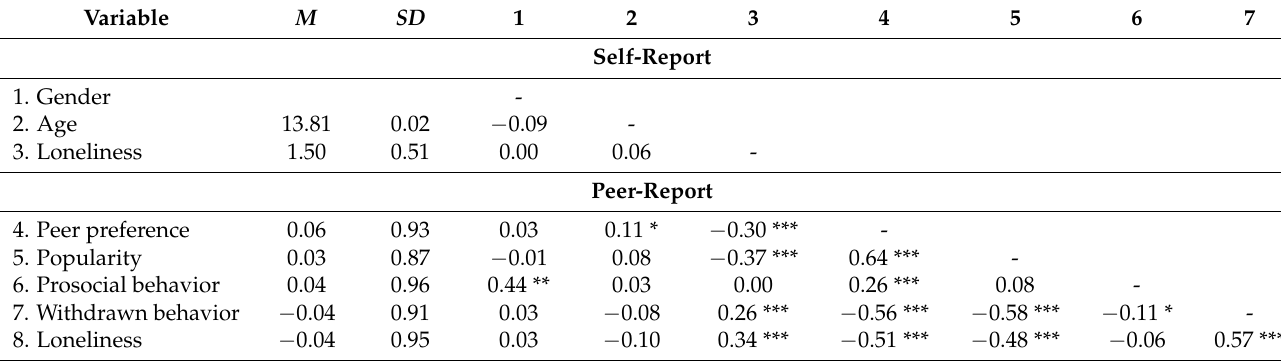
Table 4. Descriptive Statistics and Intercorrelations of Study Variables: Study 2.